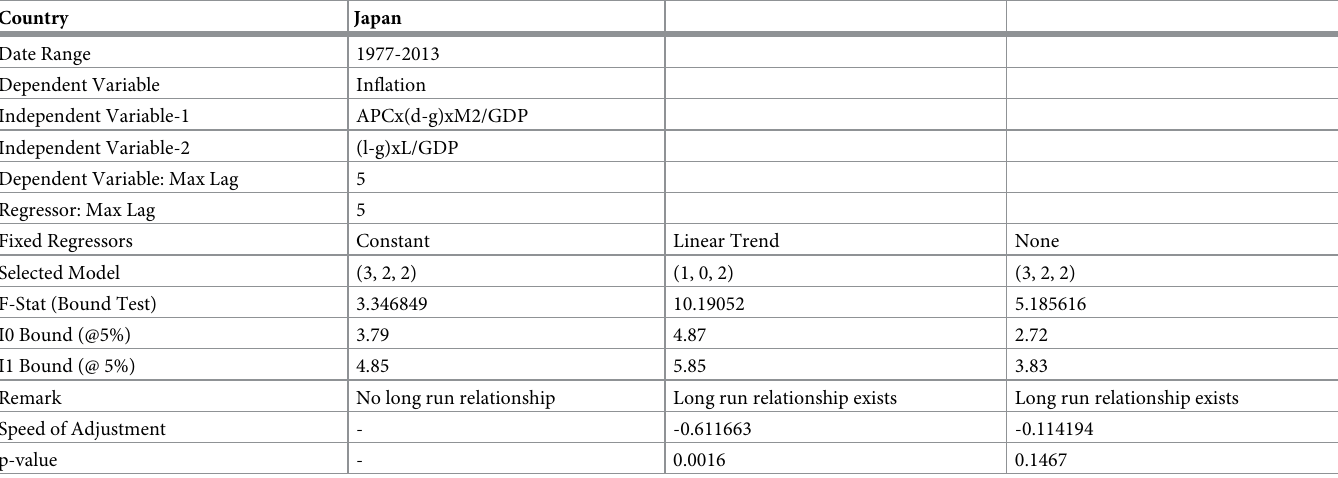
Table 22. ARDL Bounds Testing for Japanese data under proposed framework.